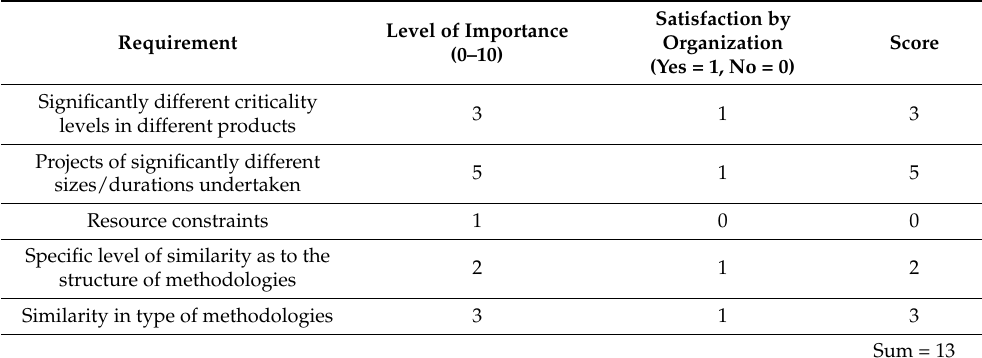
Table A1. An example of application of requirements for deciding about creating the process line.